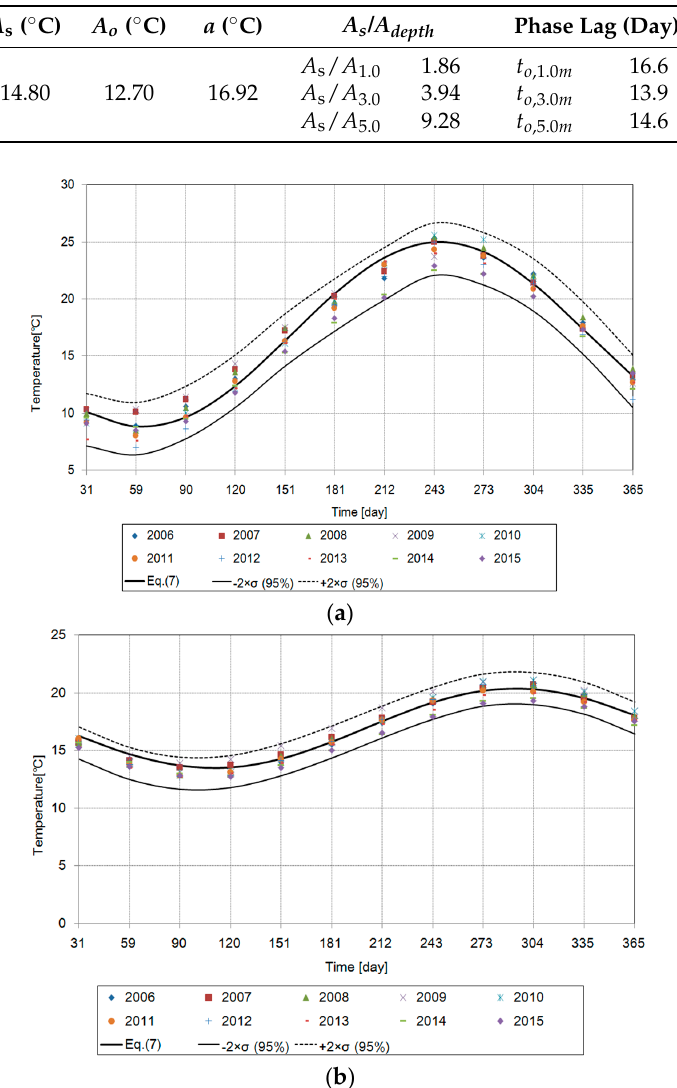
Table 1. Coefficients for estimating ground temperature in Pohang.